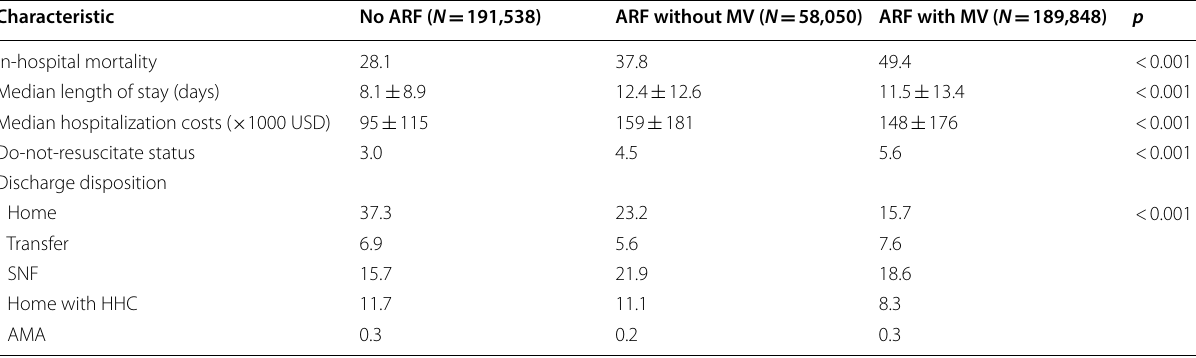
Represented as percentage or mean standard deviation; all comparisons made using one-way analysis of variance ± AMA against medical advice, AMI acute myocardial infarction, ARF acute respiratory failure, CS cardiogenic shock, HHC home health care, MV mechanical ventilation, SNF skilled nursing facility, USD US dollars